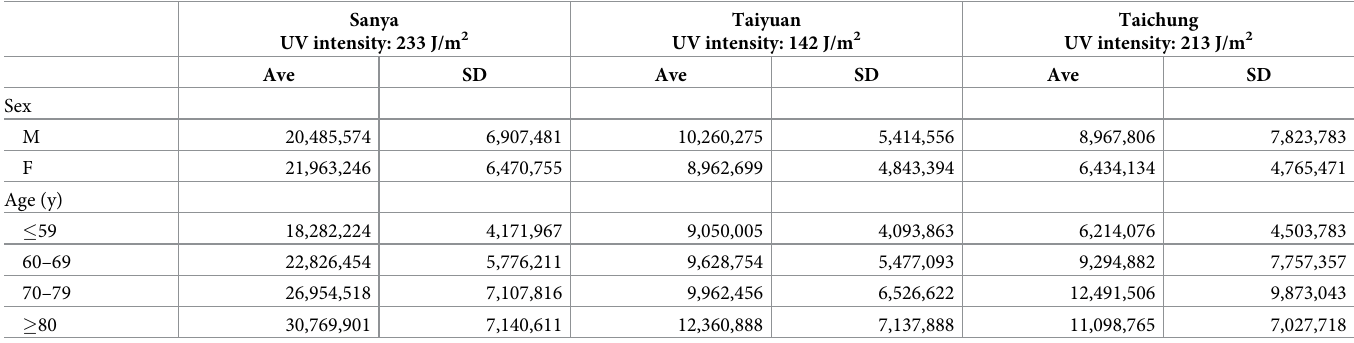
Table 3. Mean cumulative ocular UV exposure by region (stratified by sex and